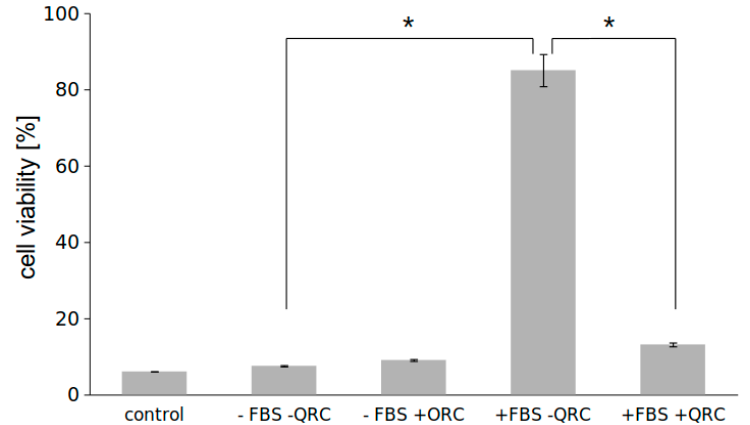
Figure 6. Viability (assessed by MTT assay) of HUVEC cells cultured on membrane inserts and allowed for the efflux of Zn-Pheide to either serum-depleted (-FBS) or serum-containing (+FBS) medium, in the presence or absence of quercetin (QRC). Cells that were not given time to remove the PS were indicated as control. Data are presented as mean ± SD from 3 inserts. Asterisks indicate significant differences between the groups, (*) indicates significant differences in cell viability between the groups, p < 0.05. We compared the morphology of HUVEC cells subjected to PDT after the incubation with 1 µM Zn-Pheide in the presence and absence of 250 µM HSA. In the cells treated with the Zn-Pheide–HSA complex, we observed a characteristic apoptotic morphology, including cell shrinkage, loss of adhesion, and the formation of apoptotic bodies (Figure 7E). When HSA was absent, in turn, the characteristic features of necrosis were observed, such as the increase in cell volume and plasma membrane blebbing (Figure 8B). These features were observed as early as 30 min after the PDT. After longer periods following PDT, we observed a significant shrinkage and detachment of the cells treated with the Zn- Pheide–HSA complex, while the cells treated solely with Zn-Pheide attached firmly to the culture vessel and appeared swollen, with plasma membrane blebs (Figure 7C). Importantly, no difference was observed between the control cells incubated with the PS in the dark with and without HSA (Figure 7A,D).